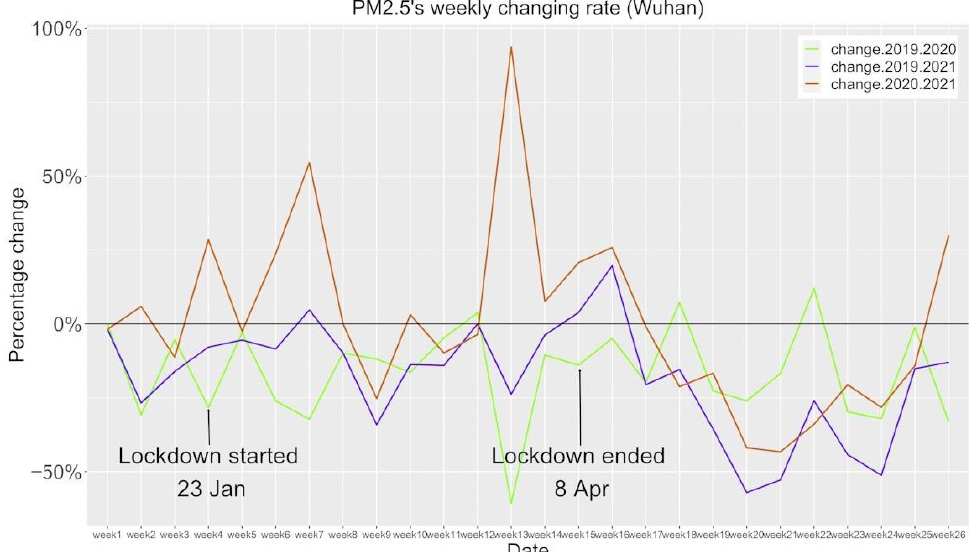
Figure 6. Weekly PM2.5 changing rate (Wuhan).